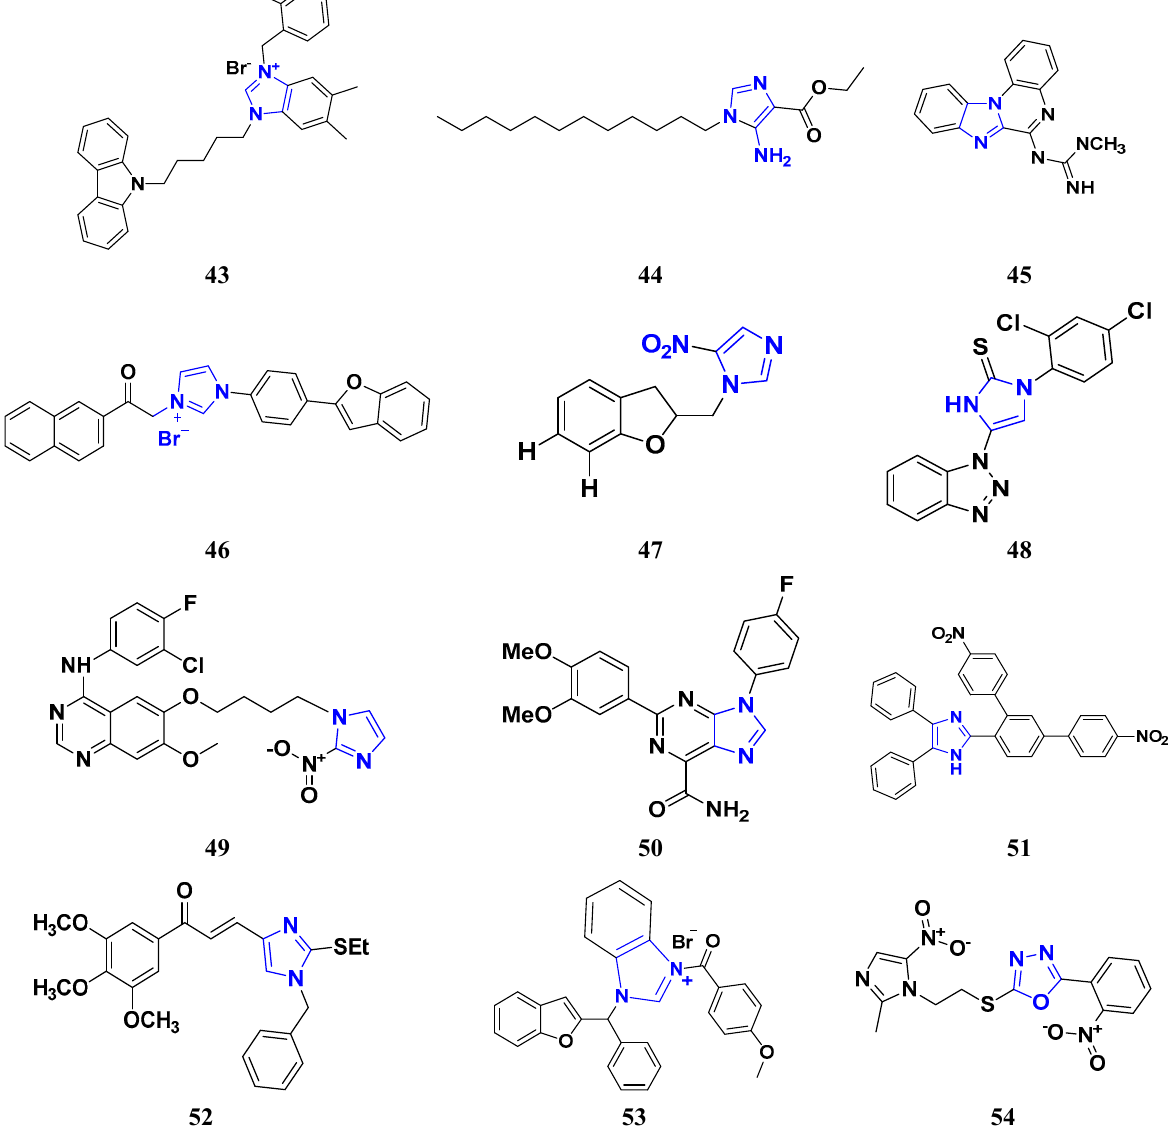
Figure 7. Imidazole derivatives ( 43 – 54 ) as anticancer agents.